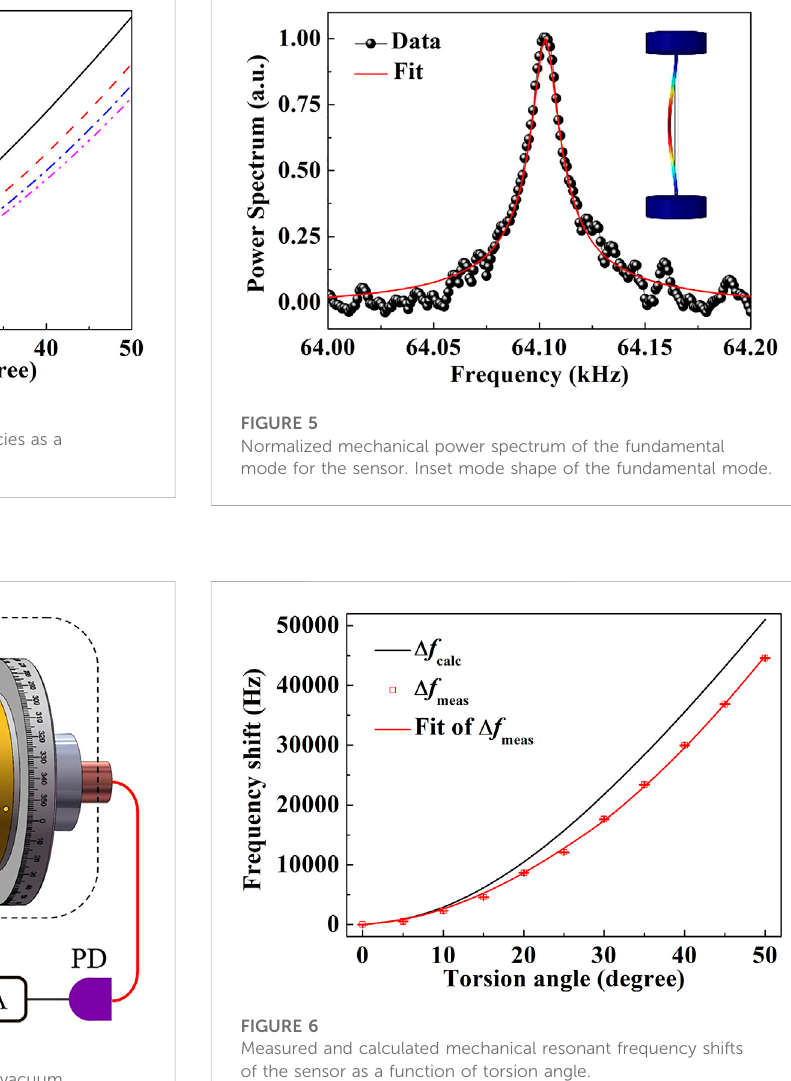
FIGURE 4 Schematic of the experimental setup, including a vacuum chamber (VC), variable optical attenuator (VOA), photodetector (PD), and electronic spectrum analyzer (ESA).